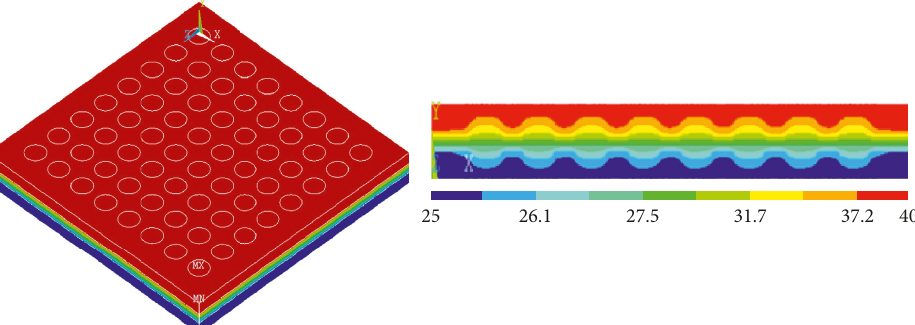
Figure 26: Overall temperature distribution diagram ( ° C).